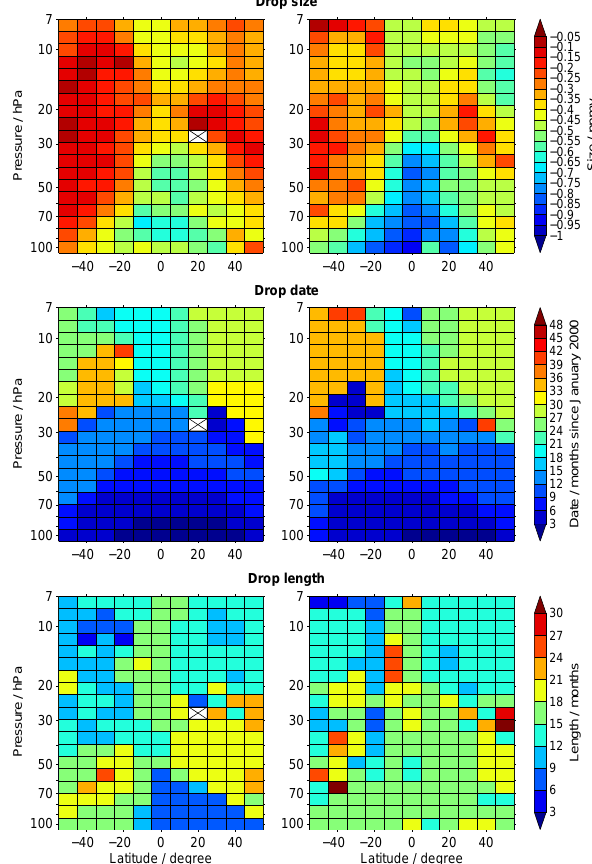
Figure 3. Characteristics of the millennium water vapour decline (phase 1) with respect to height (hPa). The analysis approach of the water vapour decline is described in the Appendix A4. Right: satel- lite observations. Left: RC1SD simulation. Top: drop size (ampli- tude)(unit: ppmv), middle: drop date (months since January 2000), bottom: drop length (duration) (unit: months). White boxes with crosses indicate that the analysis failed to find a water vapour de- crease that fulfilled the criteria listed in the Appendix A4.